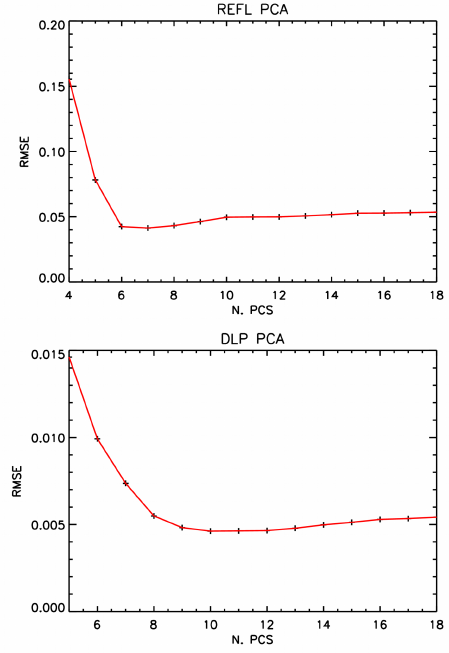
Figure 1. Reconstruction error versus number of retained principal components for the reflectances (above) and the degrees of linear polarization